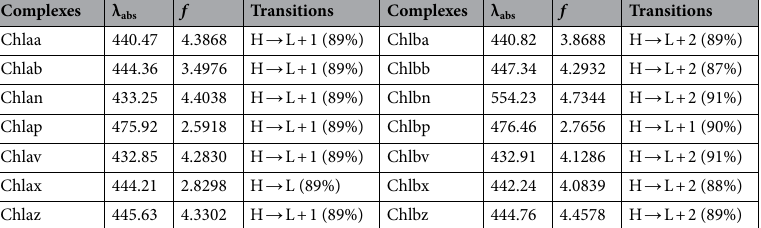
Table 4. Absorption wavelength (nm) (Singlet States), Oscillatory strength and transitions for Chla- carotenoid and Chlb-carotenoid complexes with wB97xD/Lanl2dz:6-31G** method by TDDFT in solvent (water) medium.